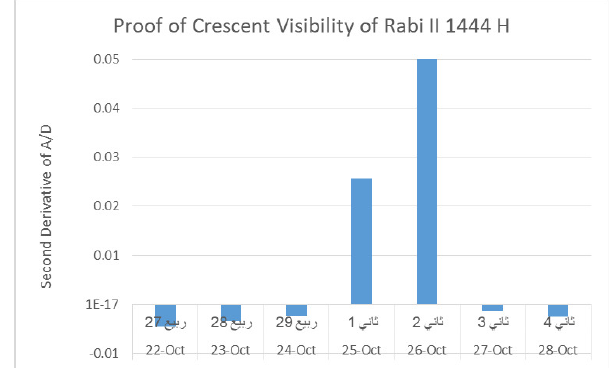
Figure 16. The Present Model Crescent Visibility of Rabi II 1444